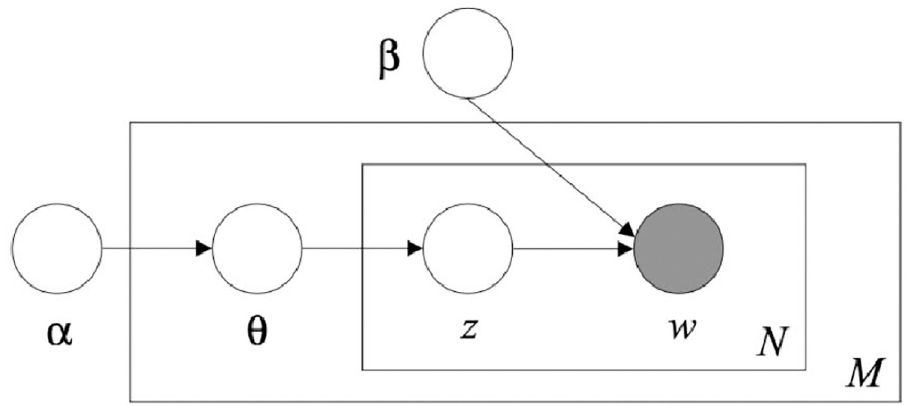
Fig 3. Original LDA